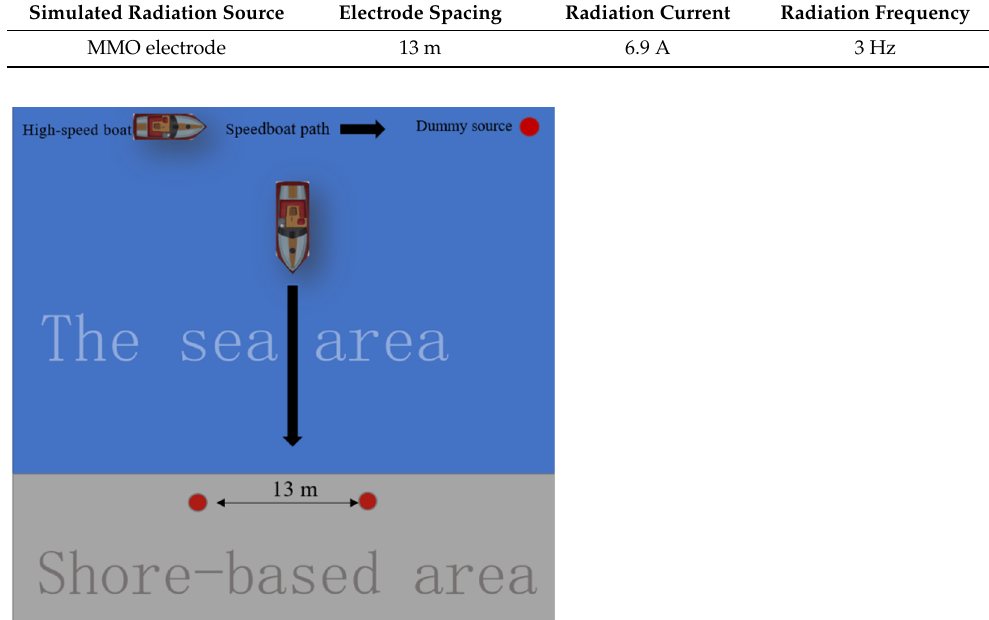
Figure 2. Actual construction drawing of measurement system.( a ) a cruciform acquisition system based on a fixed bracket; ( b ) Actual sensor laying diagram. Table 1. Parameter setting table of simulated radiation source.